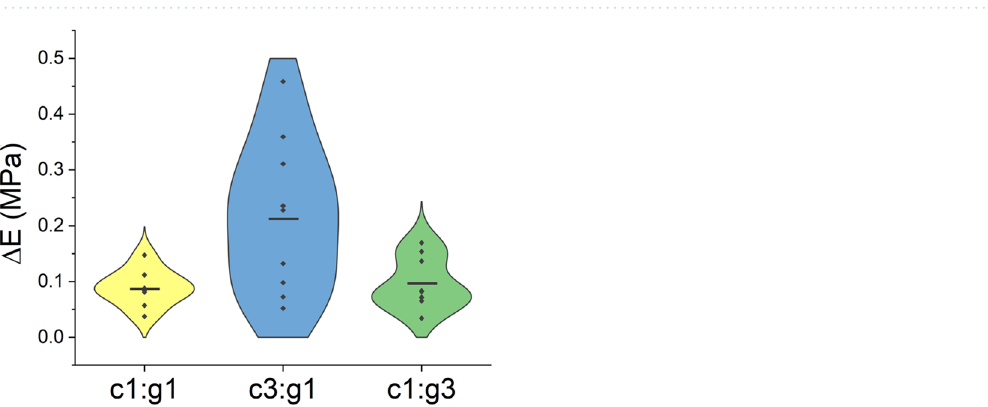
Figure 2. ( a ) Average peak load ( mean ± SD ) required in indentation per treatment group and the associated control group at 20% of applied bulk strain. ( b ) Average Young’s modulus ( mean ± SD ) for each treatment group and the associated control group.